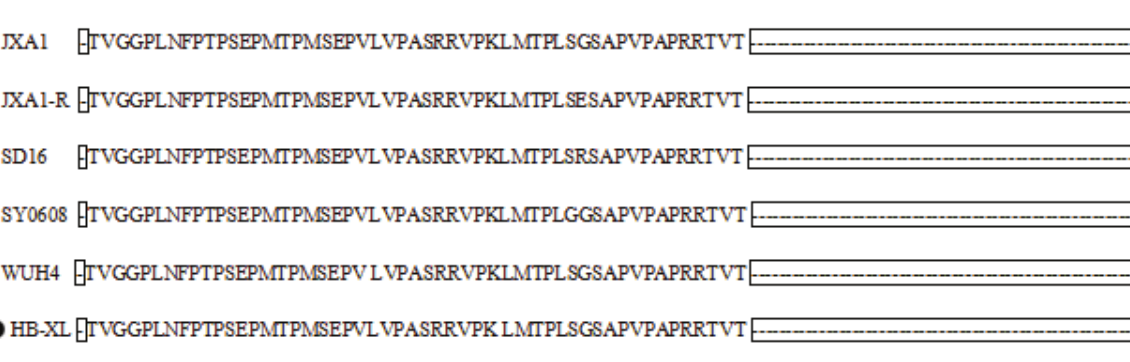
Figure 3. Alignment of the partial Nsp2 amino acid sequence of HB-XL and several representative PRRSV strains with VR2332. The amino acid deletions are shown with lines. The isolate identified in this study is indicated by a black